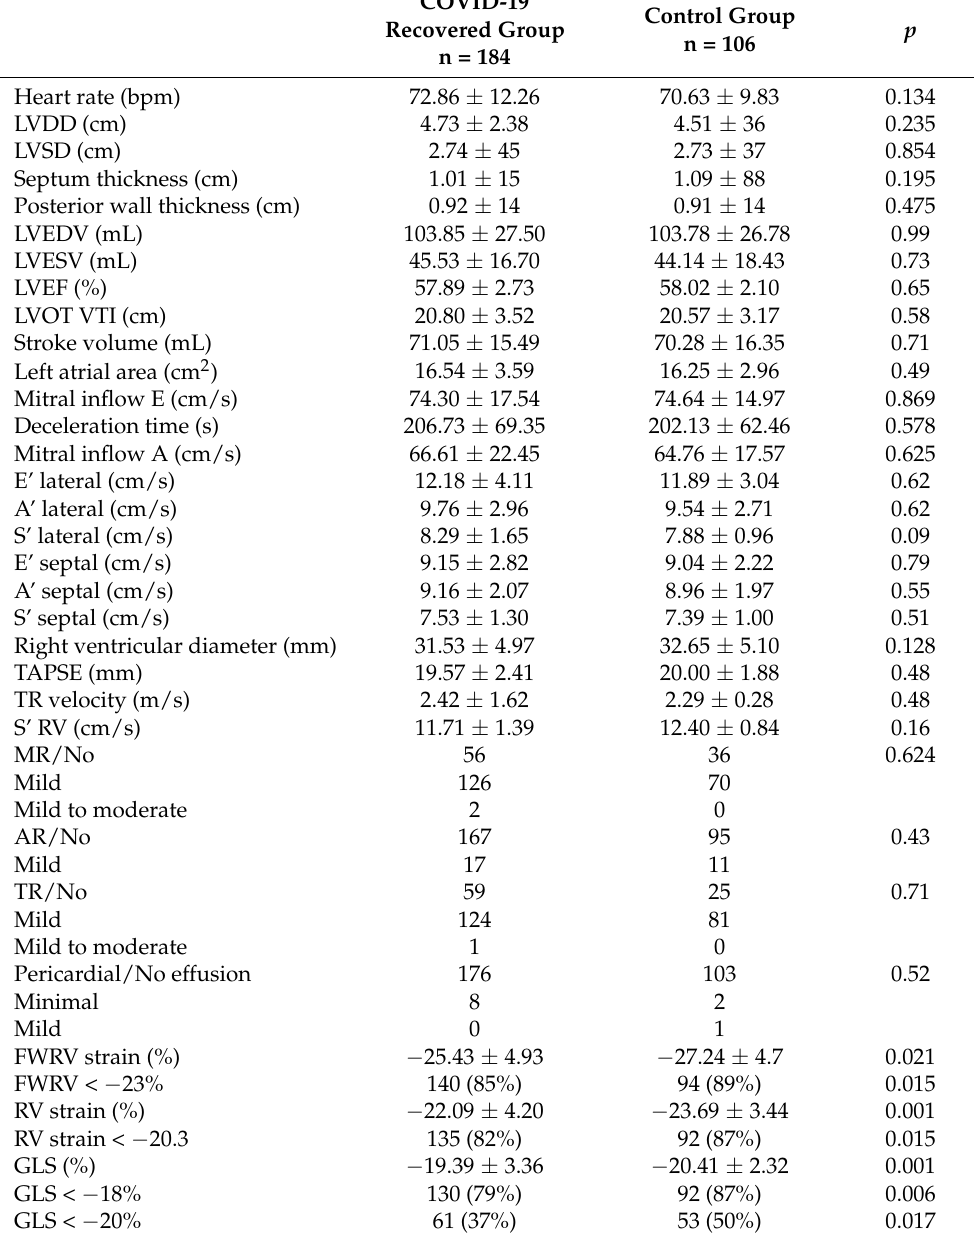
Table 2. Echocardiography parameters of COVID-19 recovered patients and control